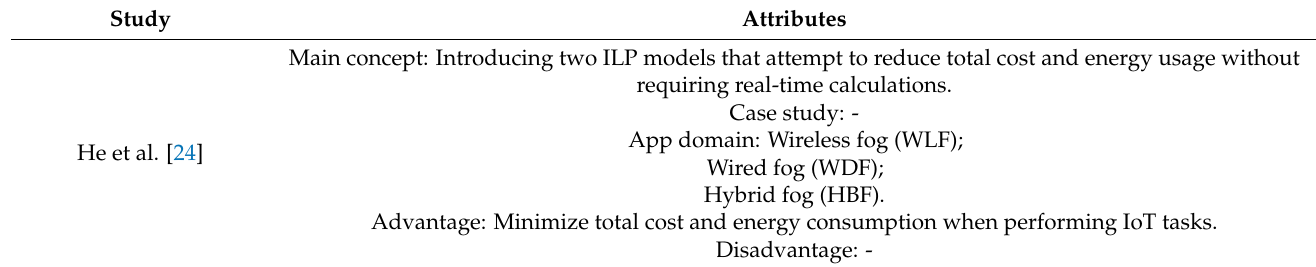
Table 16. Categorizing the state-of-the-art in energy efficiency